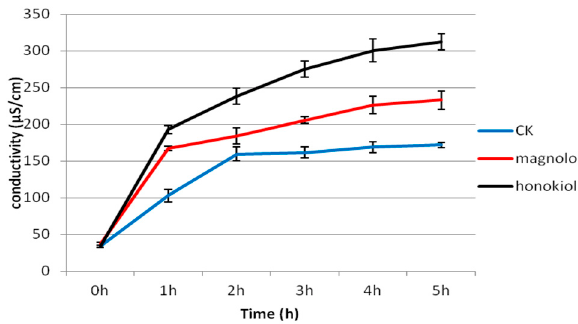
Figure 5. Effects of magnolol and honokiol on the extracellular conductivity of A. alternata , CK:PDB medium containing the same volume of Tween-20 and distilled water (1:1000 v/v ).